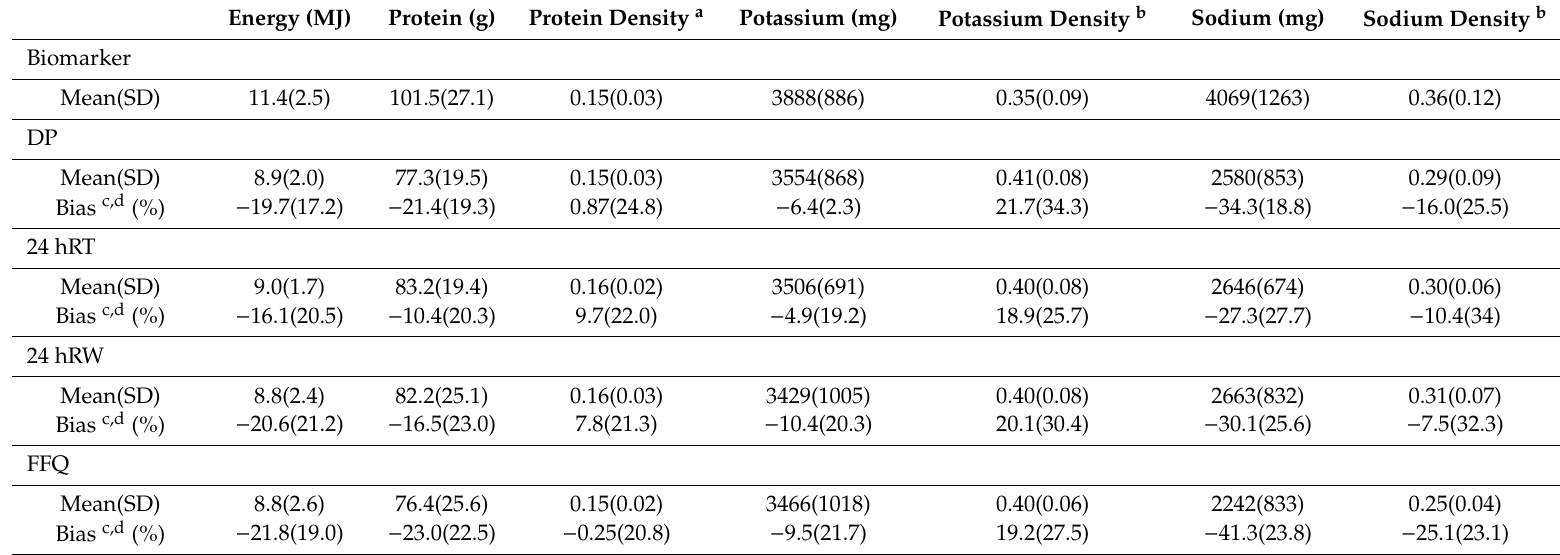
Table 1. Mean intake and bias of energy, protein, potassium, sodium, and their nutrient densities for the biomarker, DP, 24 hRT, 24 hRW and